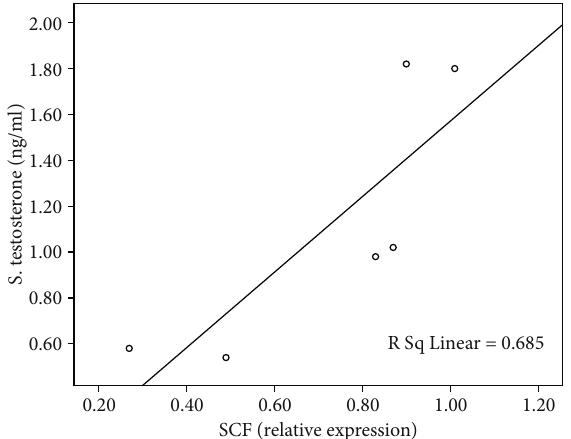
Figure 10: Scatter blot of serum level of free testosterone and SCF in homogenized testicular tissue. The simple regression model was signi fi cant, F ð 1 ‐ 4 Þ = 8 : 685 , P < 0 : 04 , and R 2 = 0 : 685 .